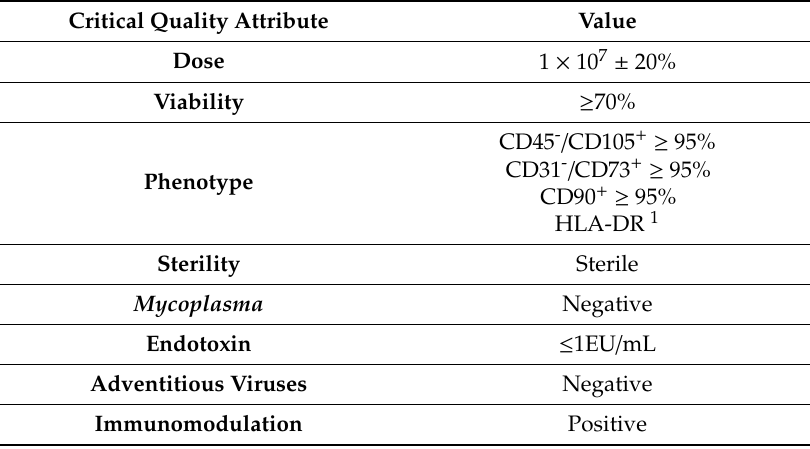
Table 2. Release criteria for drug